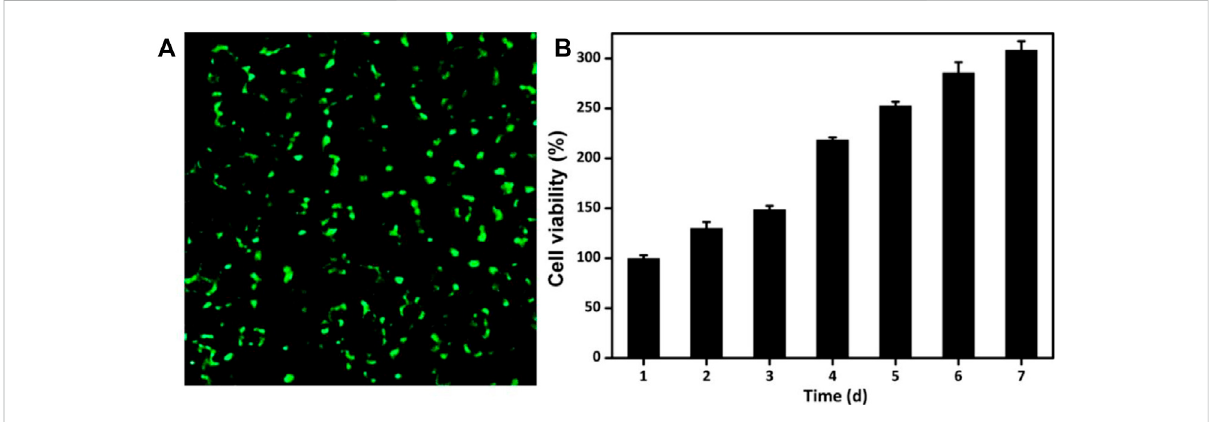
FIGURE 5 CytotoxicityofGelMA@OSA-ALNDNhydrogels invitro . (A) CLSMimagesofthecellsstainedwithalive/deadreagenton24 h.Theliveanddead cells were stained green and red, respectively. (B) Cell proliferation was detected after 7 days of